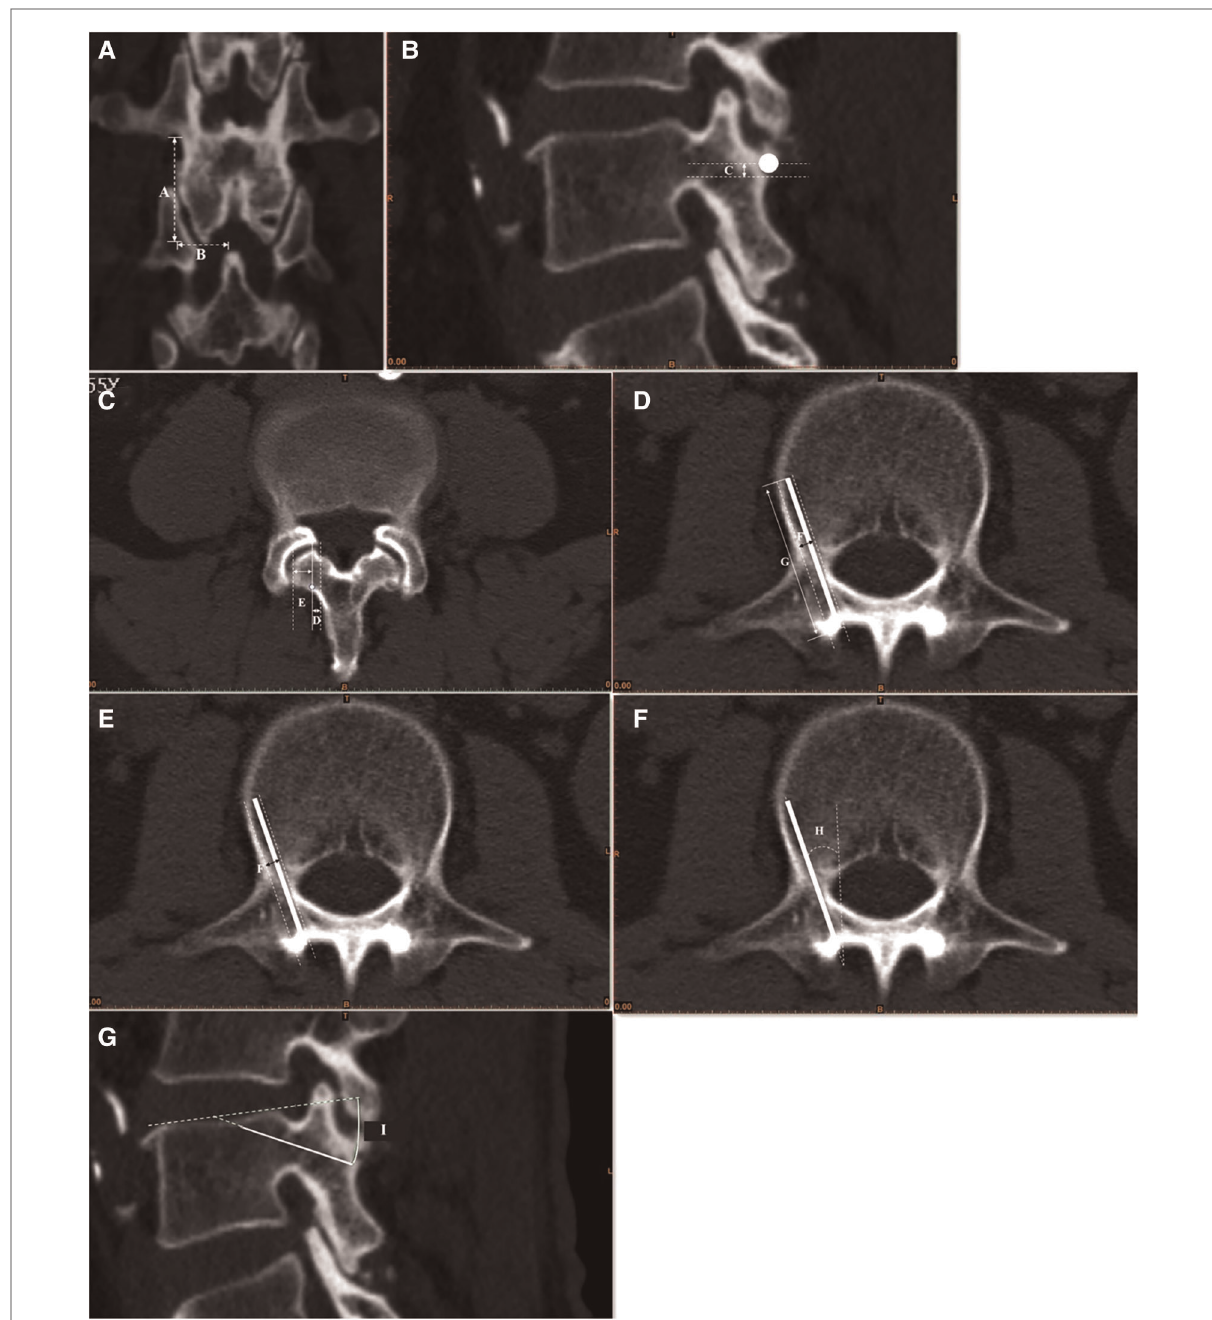
FIGURE 1 Morphometric measurement of the trajectory of the CBT screw. ( A ) The height (mm) of the lumbar pedicle (A), the width (mm) of the lumbar pedicle (B); ( B ) the distance (mm) of the inferior margin of the pedicle to the starting point (C); ( C ) the distance (mm) of the medial margin of the pedicle to the starting point (D), the distance (mm) from the starting point to the lateral margin of the pars interarticularis (E); ( D ) the maximum diameter (mm) in the transverse plane (F); ( E ) the maximum length (mm) in the sagittal plane (G); ( F ): the lateral angle (°) (H); ( G ): the cephalad angle (°)